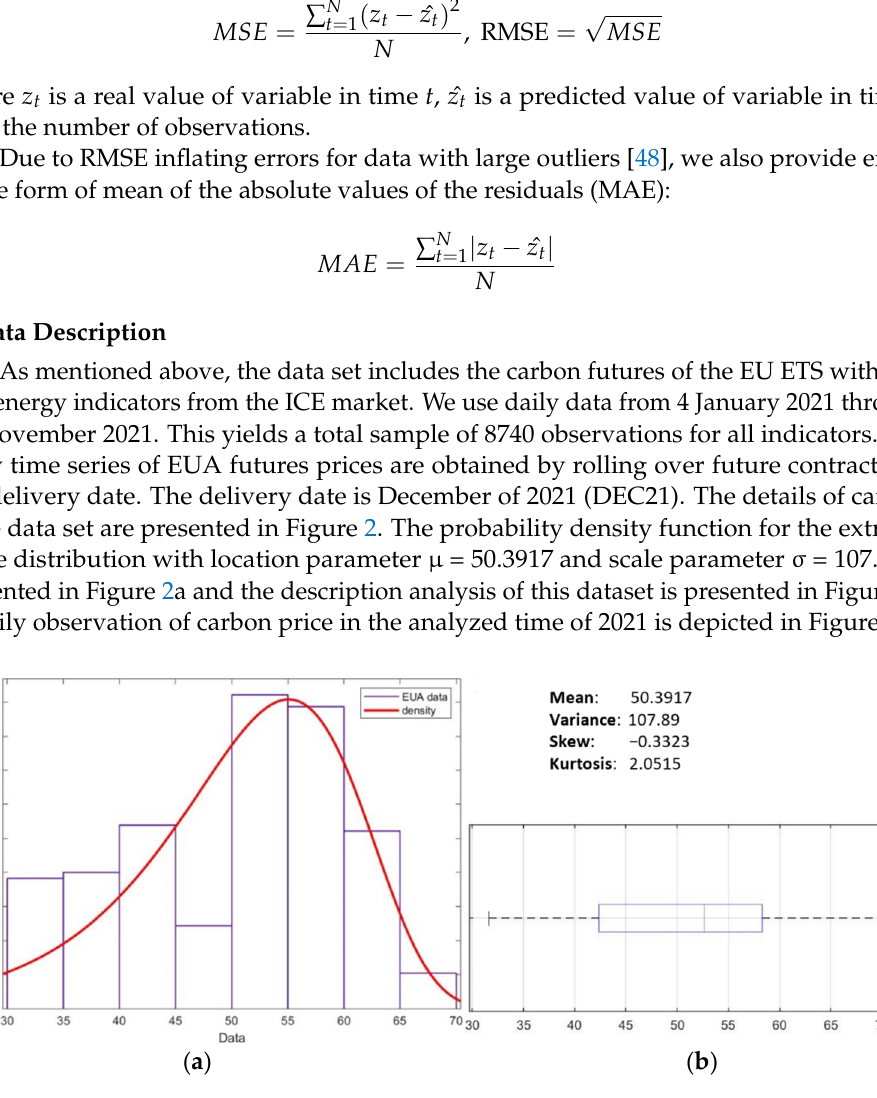
Figure 2. Description of carbon price data set: ( a ) probability density function, ( b ) description sta-